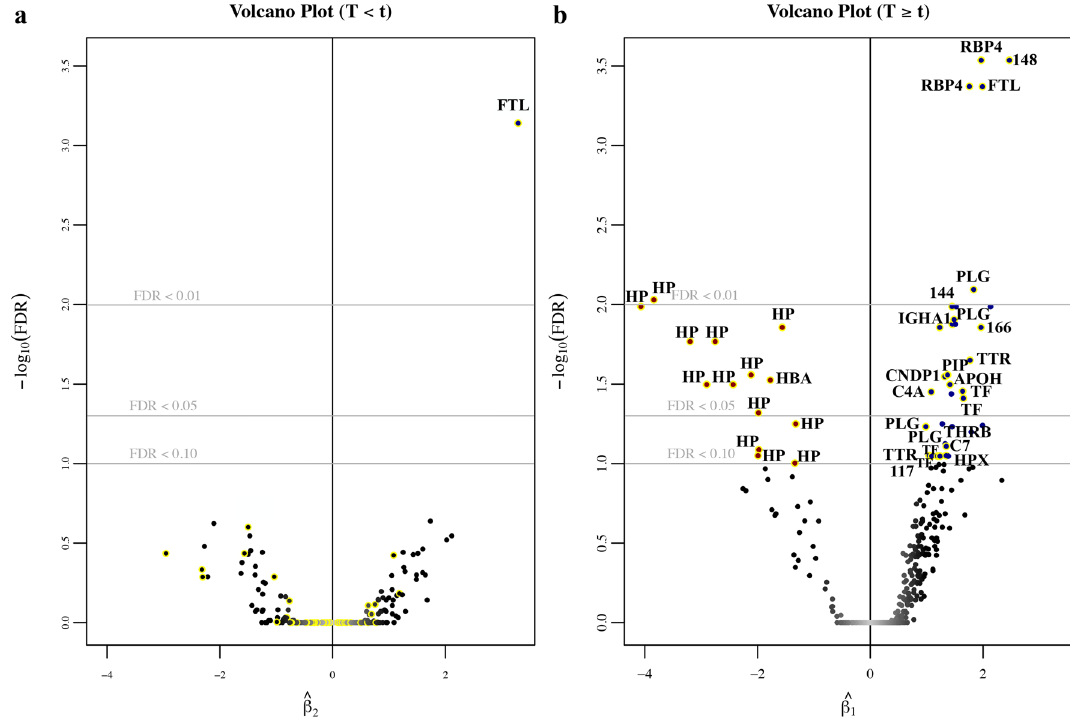
Figure 4. Volcano plot of the spline coefficients used to determine significant spots. The p-values for the spline coefficients were obtained in the natural spline model, using a single internal knot at the median HSCT time (t = 21 days after treatment). The false discovery rate (FDR) was then corrected for using the Benjamini– Hochberg procedure. ( a ) Volcano plot of the spline coefficient before (T < t) the internal knot, represented by β2, modelling for early changes during HSCT. ( b ) Volcano plot of the spline coefficient after (T ≥ t) the internal knot, represented by β1, modelling for later changes during HSCT. The x-axis represents the magnitude of change with the left side showing spots whose abundances are down-regulated and right side showing spots whose abundances are upregulated; y-axes represent log-transformed FDR values. The smaller the FDR value and thus higher –log10(FDR) value, the more significant the spot is.